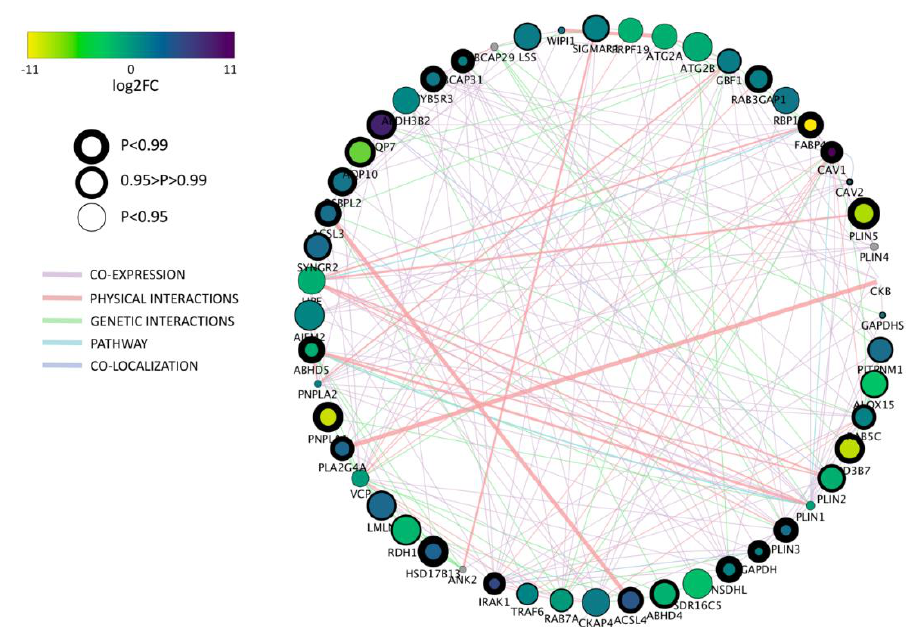
Figure 4. Heatmap of gene ontology (GO) term “lipid storage” representing porcine and bovine parthenogenetic, blastocyst stage embryos, ICM and TE cell lines.